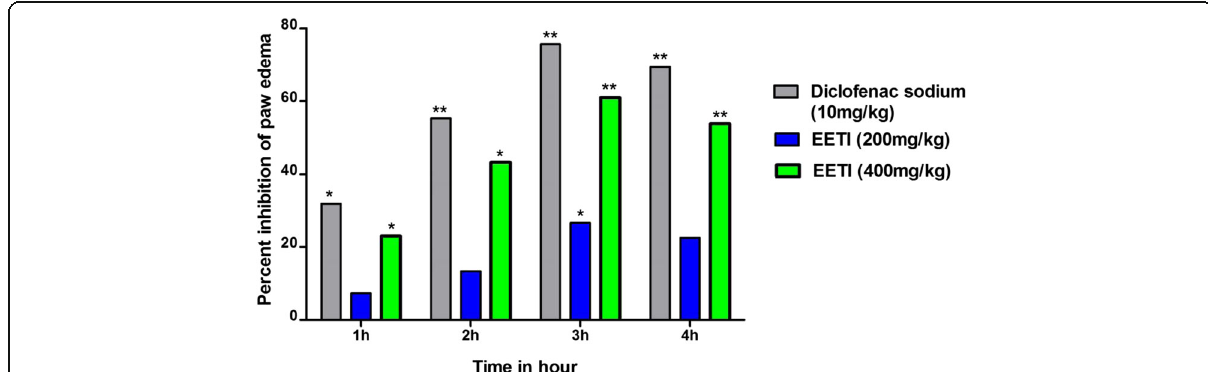
Fig. 1 Anti-inflammatory effect of EETI on Carrageenan-induced paw edema test. Each point percent inhibition of paw edema after 1, 2, 3 and 4 h of treatment. The data was analyzed by ANOVA followed by Dunnett ’ s test. Asterisks indicated statistically significant values from control. * p < 0.05 , ** p <